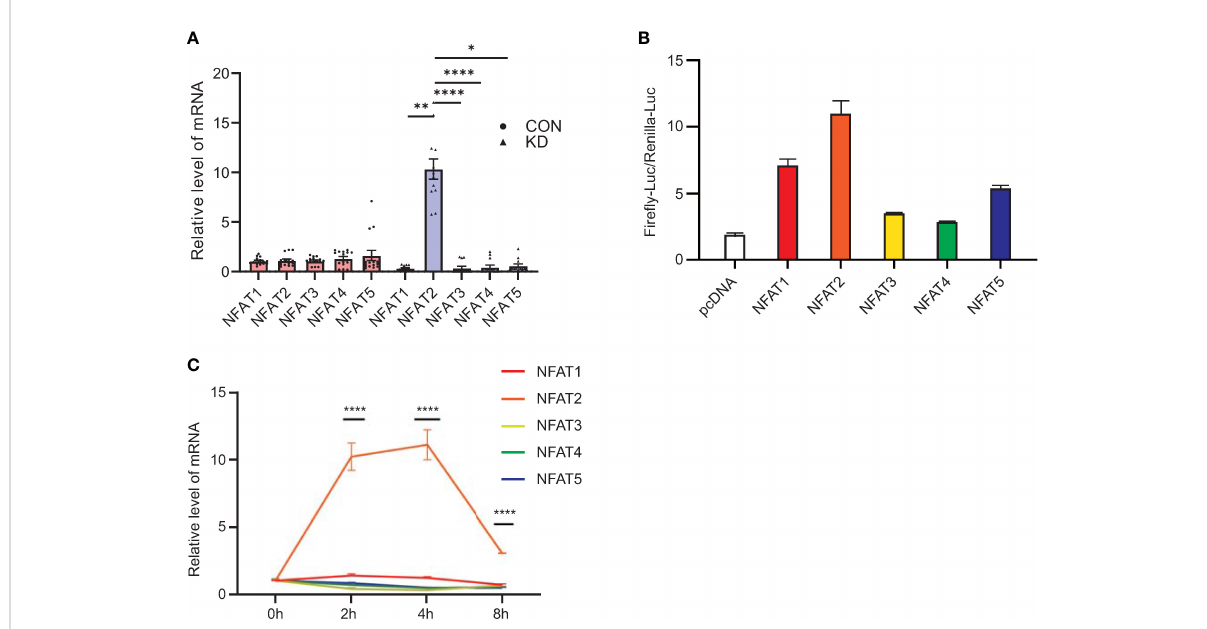
FIGURE 1 Levels of NFAT2 mRNA increase during Kawasaki Disease progression. (A) qRT-PCR results for peripheral blood mononuclear cells (PBMCs) in blood samples from patients with Kawasaki Disease (n = 12) and healthy controls (n = 15). (B) 293T cells were transfected with control plasmid or NFAT1 ~ NFAT5 , together with NFAT_Luc and Renilla plasmids respectively. The cells were harvested 72 hours after transfection. The relative activity of NFAT-driven fi re fl y luciferase activity was normalized to that of Renilla luciferase activity (Fire fl y-luc/Renilla-luc). (C) qRT-PCR results of NFAT family members in HCAEC that were stimulated by TNF a (40 ng/ml) at different timepoints (n = 3). Data are presented as the mean ± SEM. Quantitative data were analyzed using the Kruskal – Wallis test (A) and one-way ANOVA (C) , *P < 0.05, **P < 0.01, ****P < 0.0001. CON, control group; KD, Kawasaki Disease; NFAT, nuclear factor of activated T cells; HCAEC, Human coronary artery endothelial cells; ANOVA, analysis of